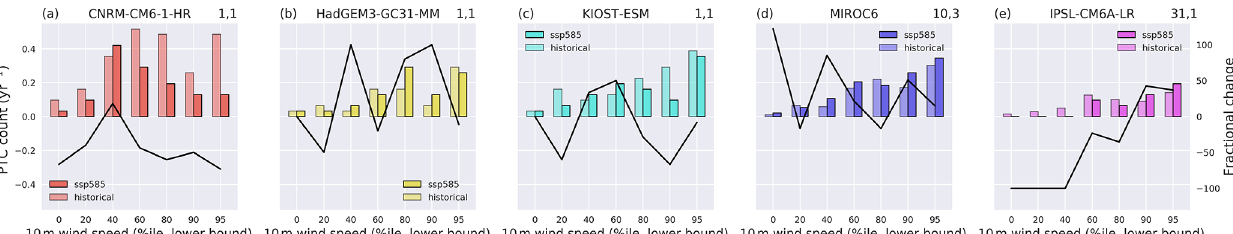
Figure 9. Bar plot showing the number of Europe-impacting PTCs (per ensemble member) in each intensity bin for the five selected CMIP6 models for the historical (1984–2014, lighter colours) period and towards the end of the century under the SSP5-85 scenario (2069–2099, darker colours). Fractional change in the counts in the future period compared to historical is shown as the black line corresponding to the right-hand-side y axis. Number of ensemble members used for the historical and future periods are shown in the upper right of each panel (historical,